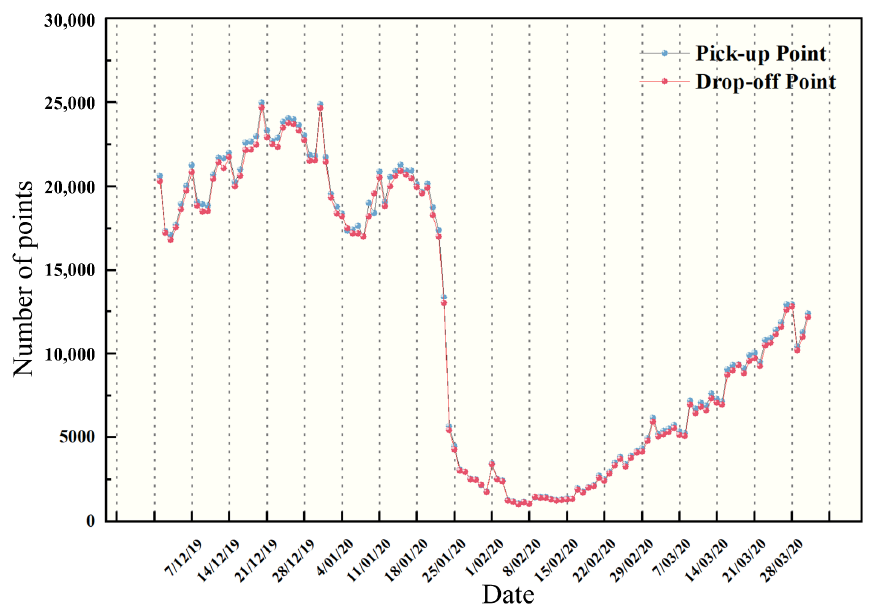
Figure 5. Daily change in residential travel volume.